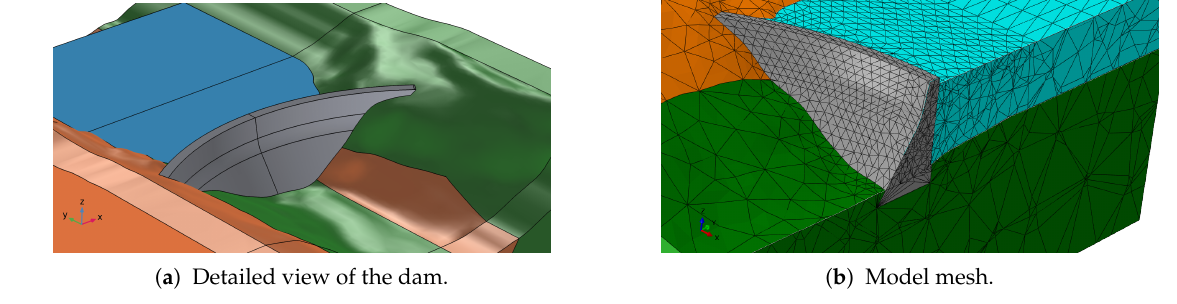
Figure 3. Numerical model of the analysed